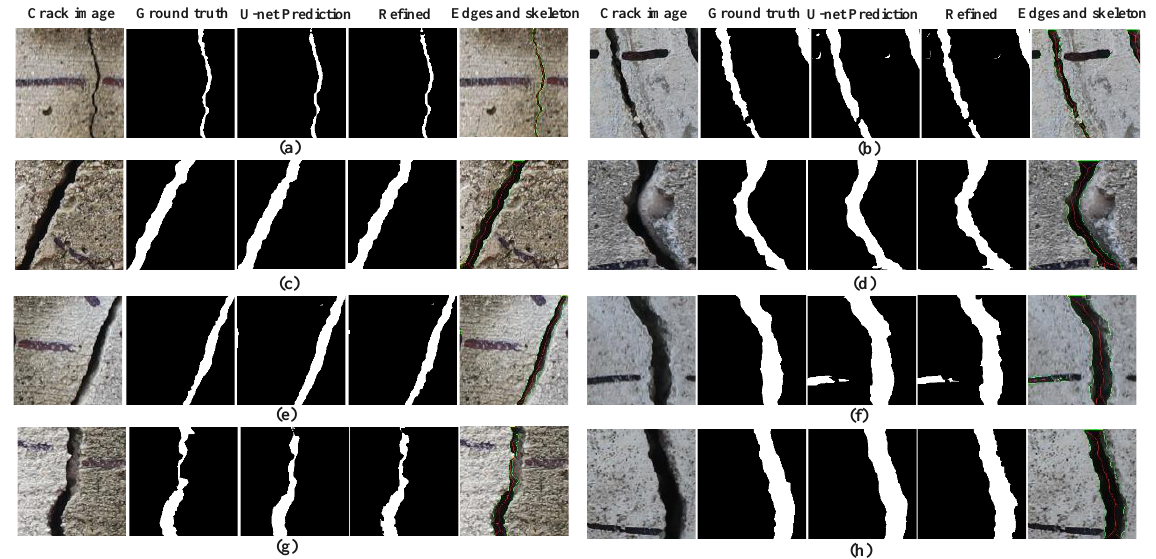
Figure 25. Cracks on concrete dam pier with different background and segmentation results. ( a ) narrow crack, ( b ) artificial mark interference, ( c ) boundaries refinement, ( d ) blurry boundaries, ( e ) accurate segmentation, ( f ) artificial mark interference, ( g ) blurry boundaries, ( h ) boundaries refinement.